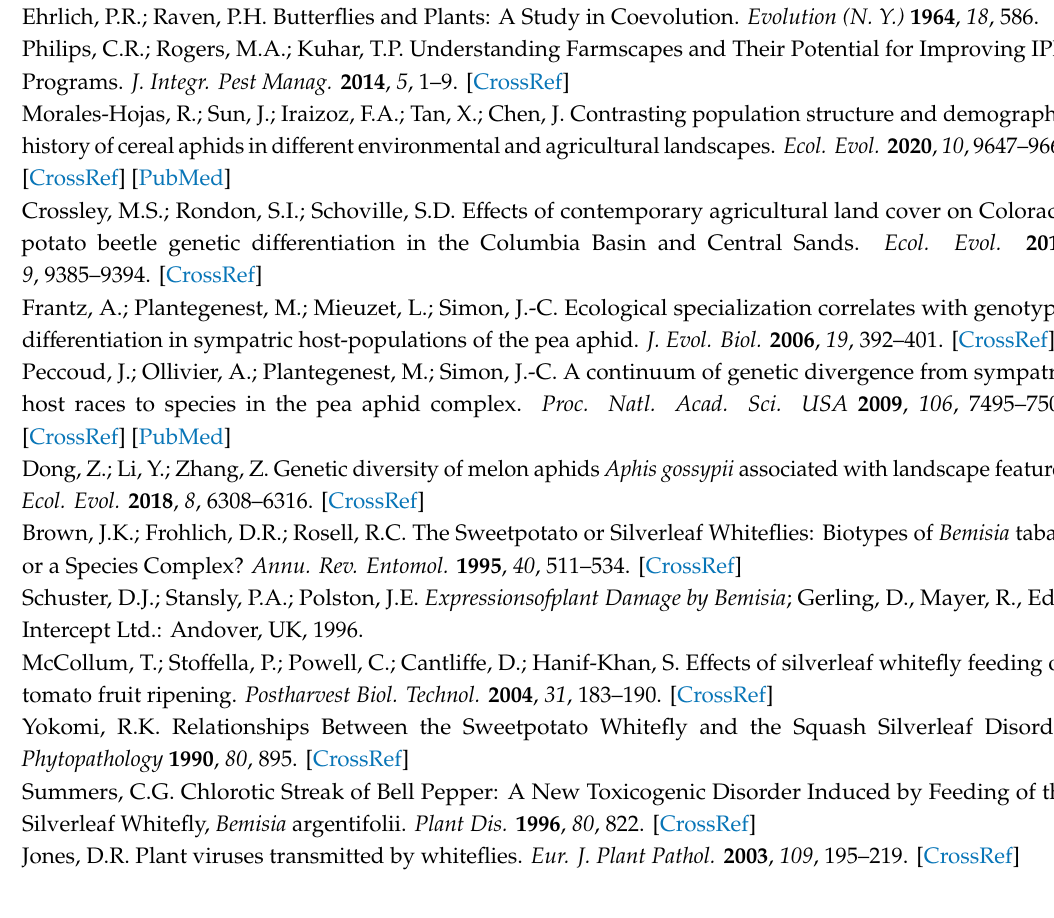
Figure S1: Bayesian clustering analysis results for 35 B. tabaci MEAM1 populations based on six microsatellite markers using STRUCTURE v.2.3.2. Structure bar plots at K =